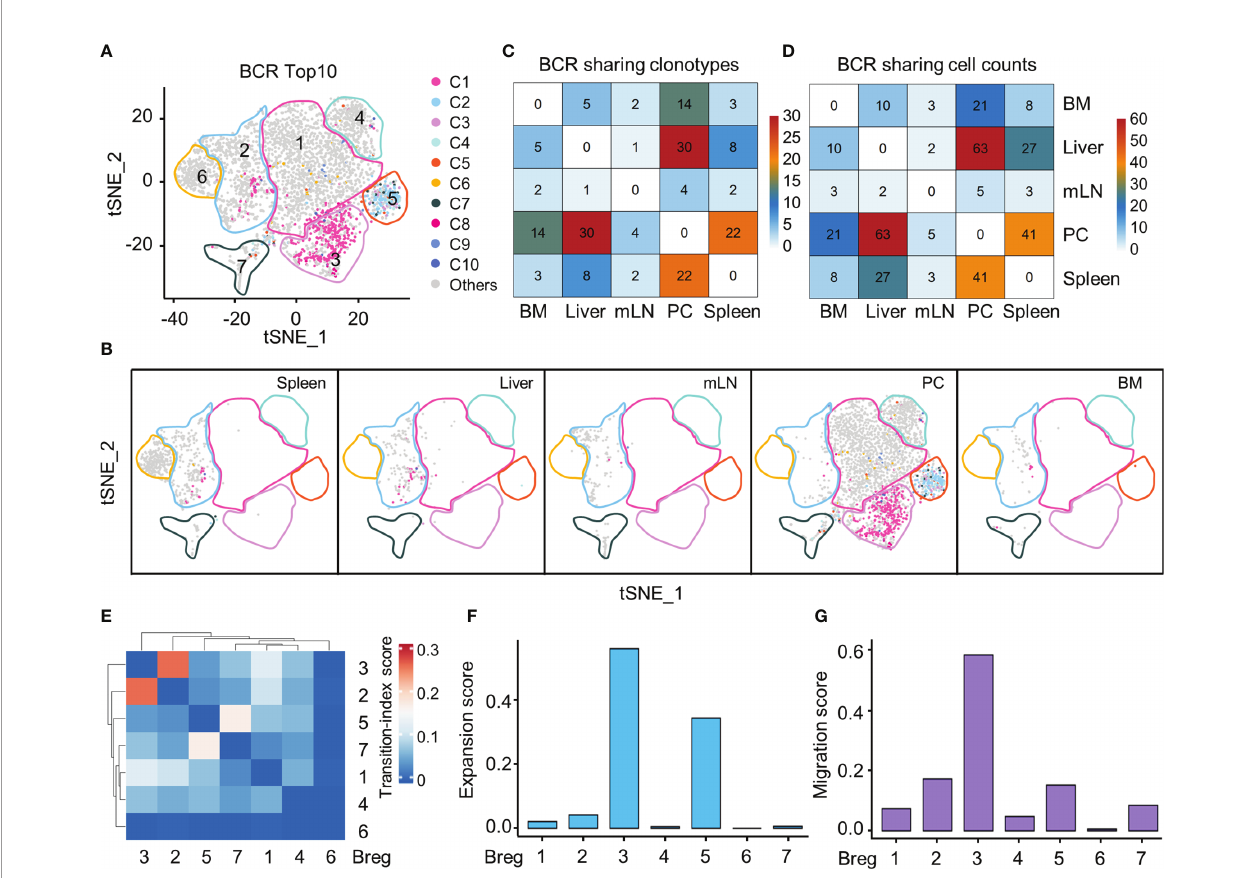
FIGURE 4 | Clonal expansion and potential migration of Breg cells subsets at scBCR-seq. (A) The distribution of top 10 BCR clonotypes in Breg cells clusters of all organs. (B) t-SNE plot of top 10 BCR clonotypes of Breg cells in each organ. (C) Sharing of Breg cell BCR clonotypes across pairwise organs. (D) Sharing of Breg cell and BCR cell counts across pairwise organs. (E) Heat map of transition-index scores for the pairwise Breg cell clusters from all organs. (F) Expansion-index scores of each Breg cluster from all organs calculated using STARTRAC. (G) Migration-index scores of each Breg cluster from all organs calculated using